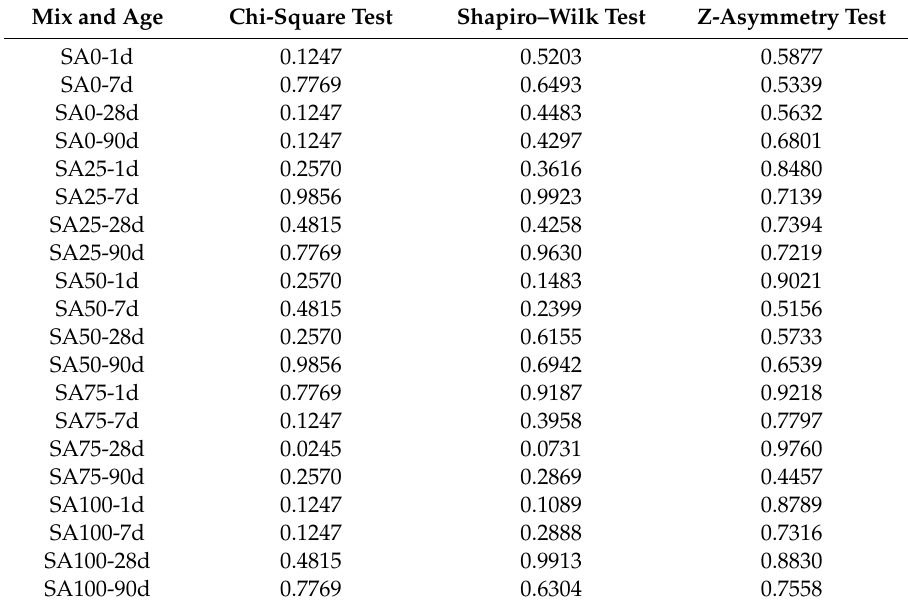
Table 9. p -value for the normality tests of the compressive strength of each mixture at each